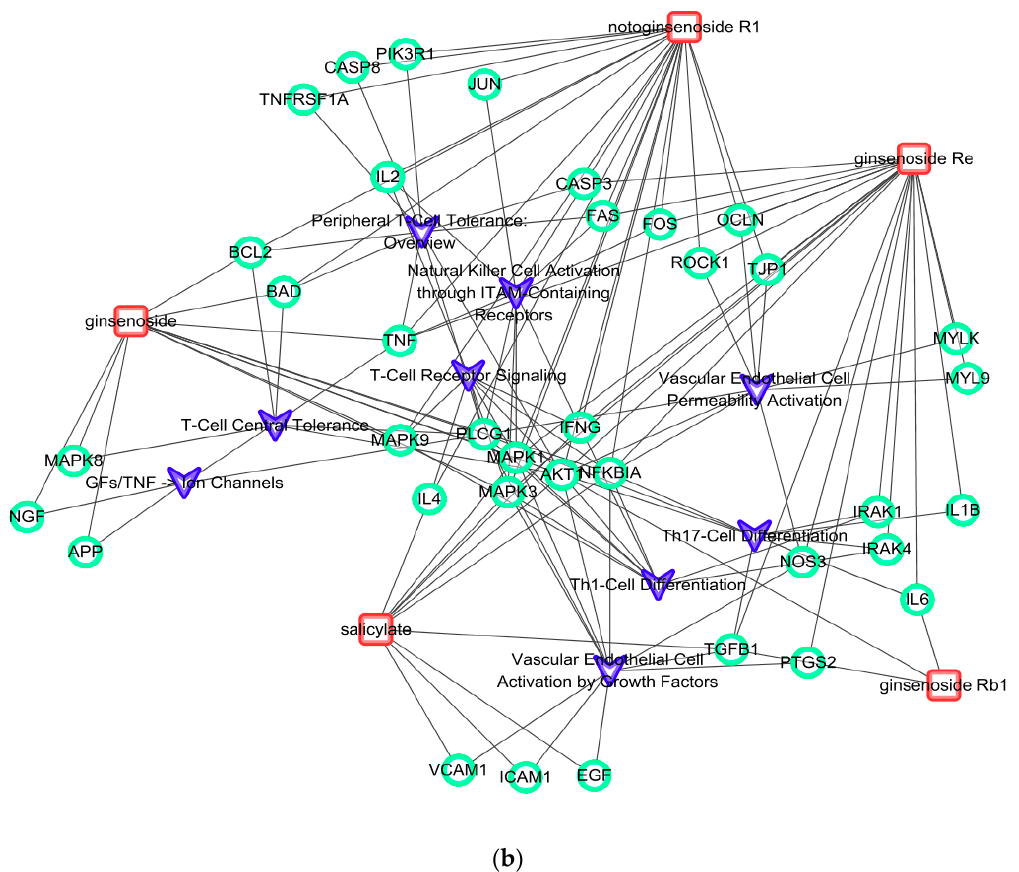
Figure 5. ( a ) Herb-component-target / pathway-phenotype network. ( b ) Component-target-pathway network of red ginseng. Components (red), targets (green), and pathways (blue). Cytoscape file was included as supplementary information (Figure S3).